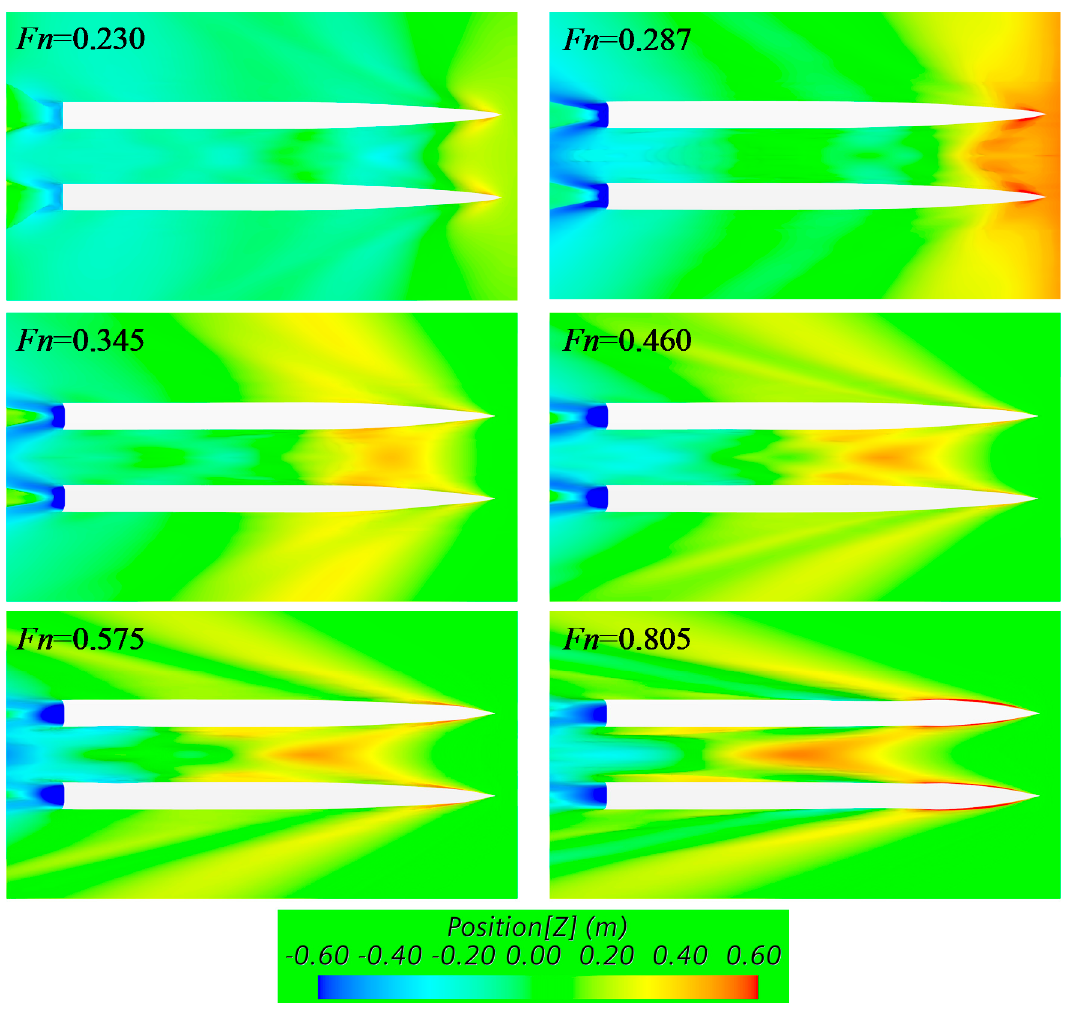
Figure 15. The wave interaction between demihulls in shallow water.